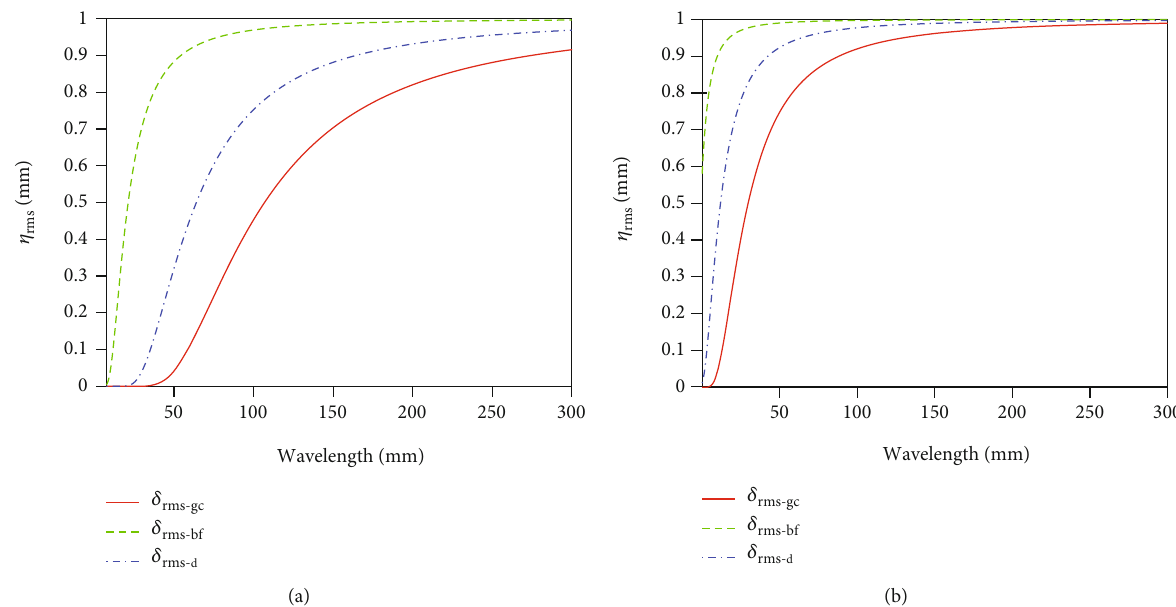
Figure 18: Comparison of re fl ector gain e ffi ciency factor η δ for (a) the center-feed mesh re fl ector and (b) the o ff set-feed mesh re fl rms − d